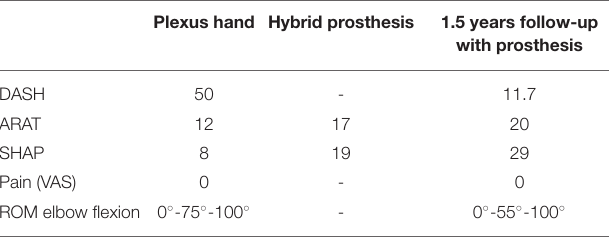
TABLE 1 | Results of the assessments with the plexus hand, the hybrid prosthesis and the final prosthesis (1.5 years